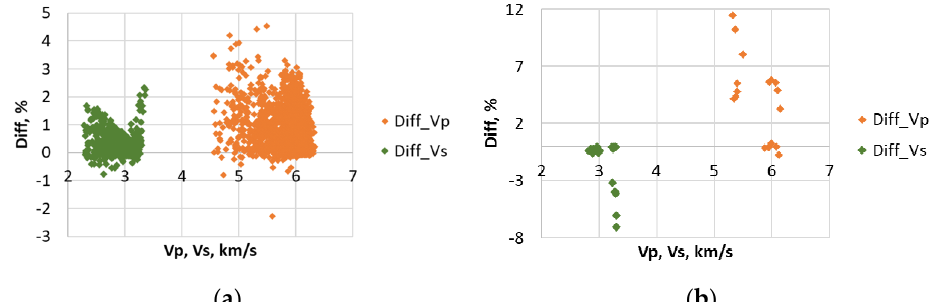
Figure 5. Relative difference (Diff) between the theoretical and experimental values of compressional (orange signs) and shear (green signs) wave velocities. ( a ) West Siberian limestones and ( b ) limestones from layers within a shale formation [54]. The horizontal axis shows experimental velocity values.